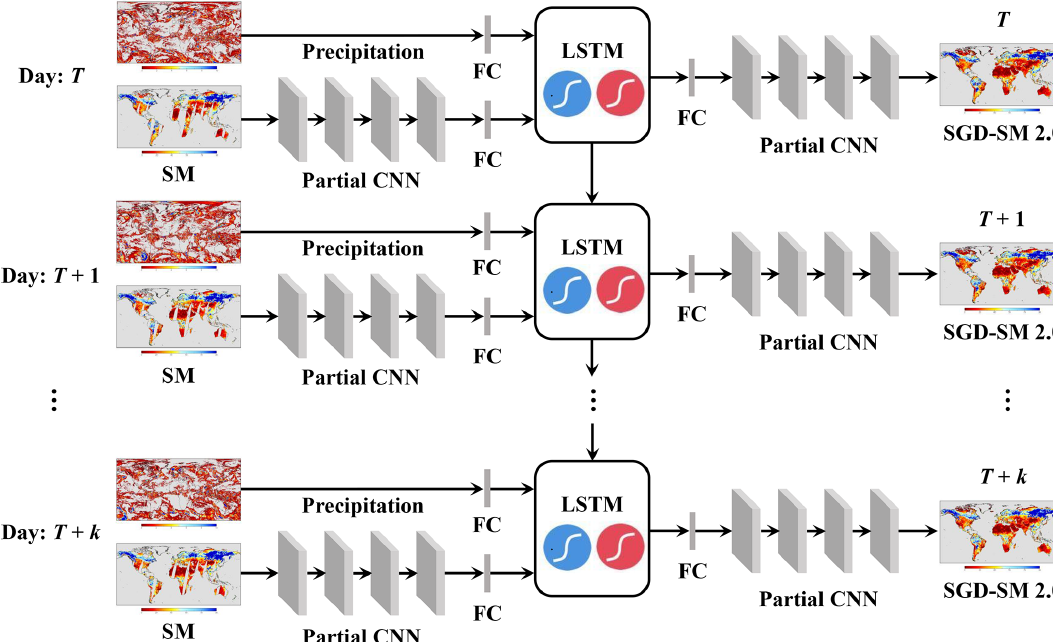
Figure 4. Schematic representation of the proposed framework to generate SGD-SM 2.0 products.